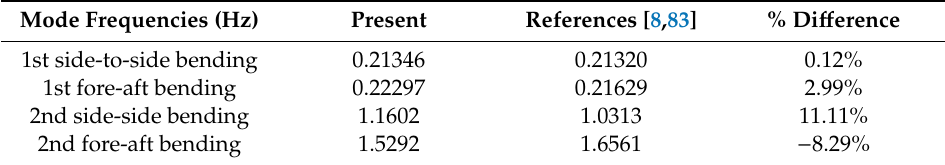
Table 6. Comparison of the support structure mode frequencies with reference